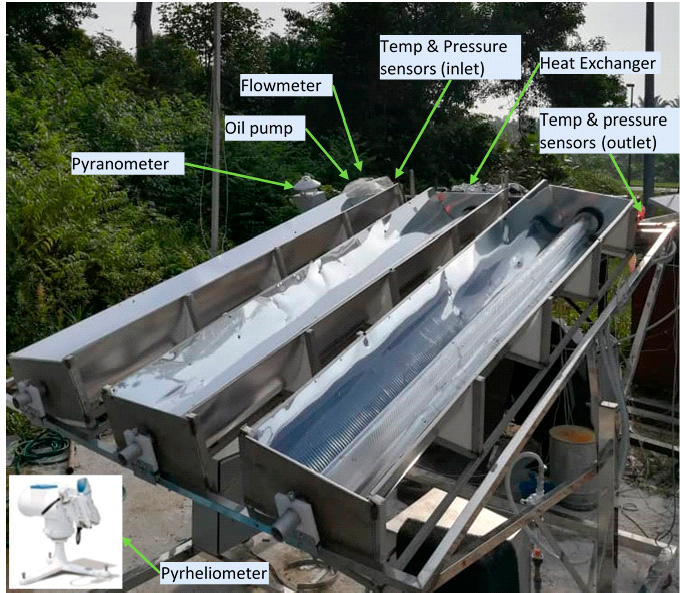
Figure 7. Actual photograph of the experimental test rig.